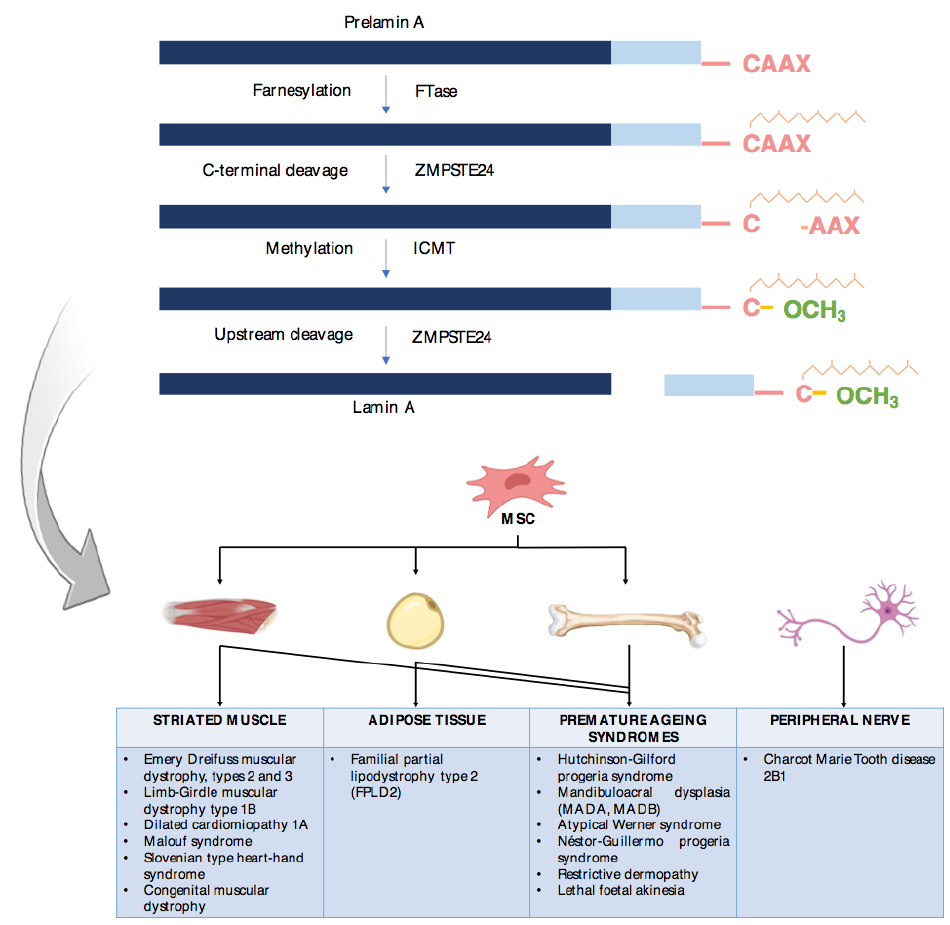
Figure 1. Lamin A processing pathway and laminopathies affecting mesenchymal tissues. Prelamin A is farnesylated, methylated and processed by ZMPSTE24, giving rise to the mature lamin A. Alterations in this lamin A processing pathway are responsible for several disorders known as laminopathies, which mainly affect mesenchymal tissues. In this figure, laminopathies are distributed according to the most characteristically affected mesenchymal tissue (adipose tissue in the case of type 2 familial partial lipodystrophy). MSC: mesenchymal stem cell.